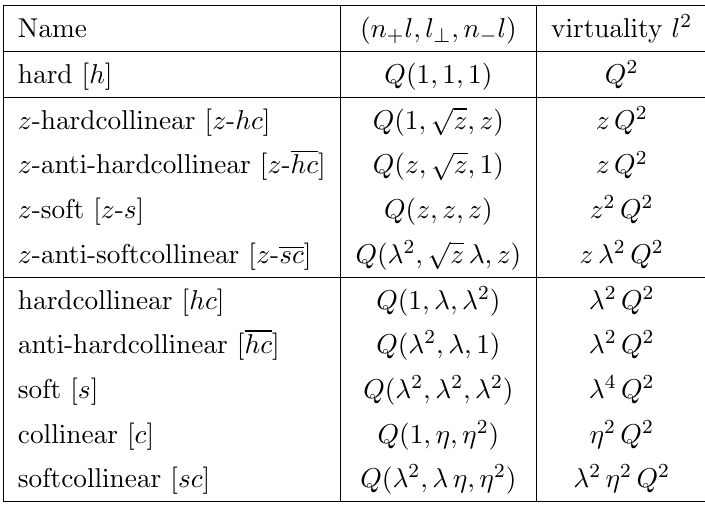
Table 1 . Scaling of the momentum modes relevant for